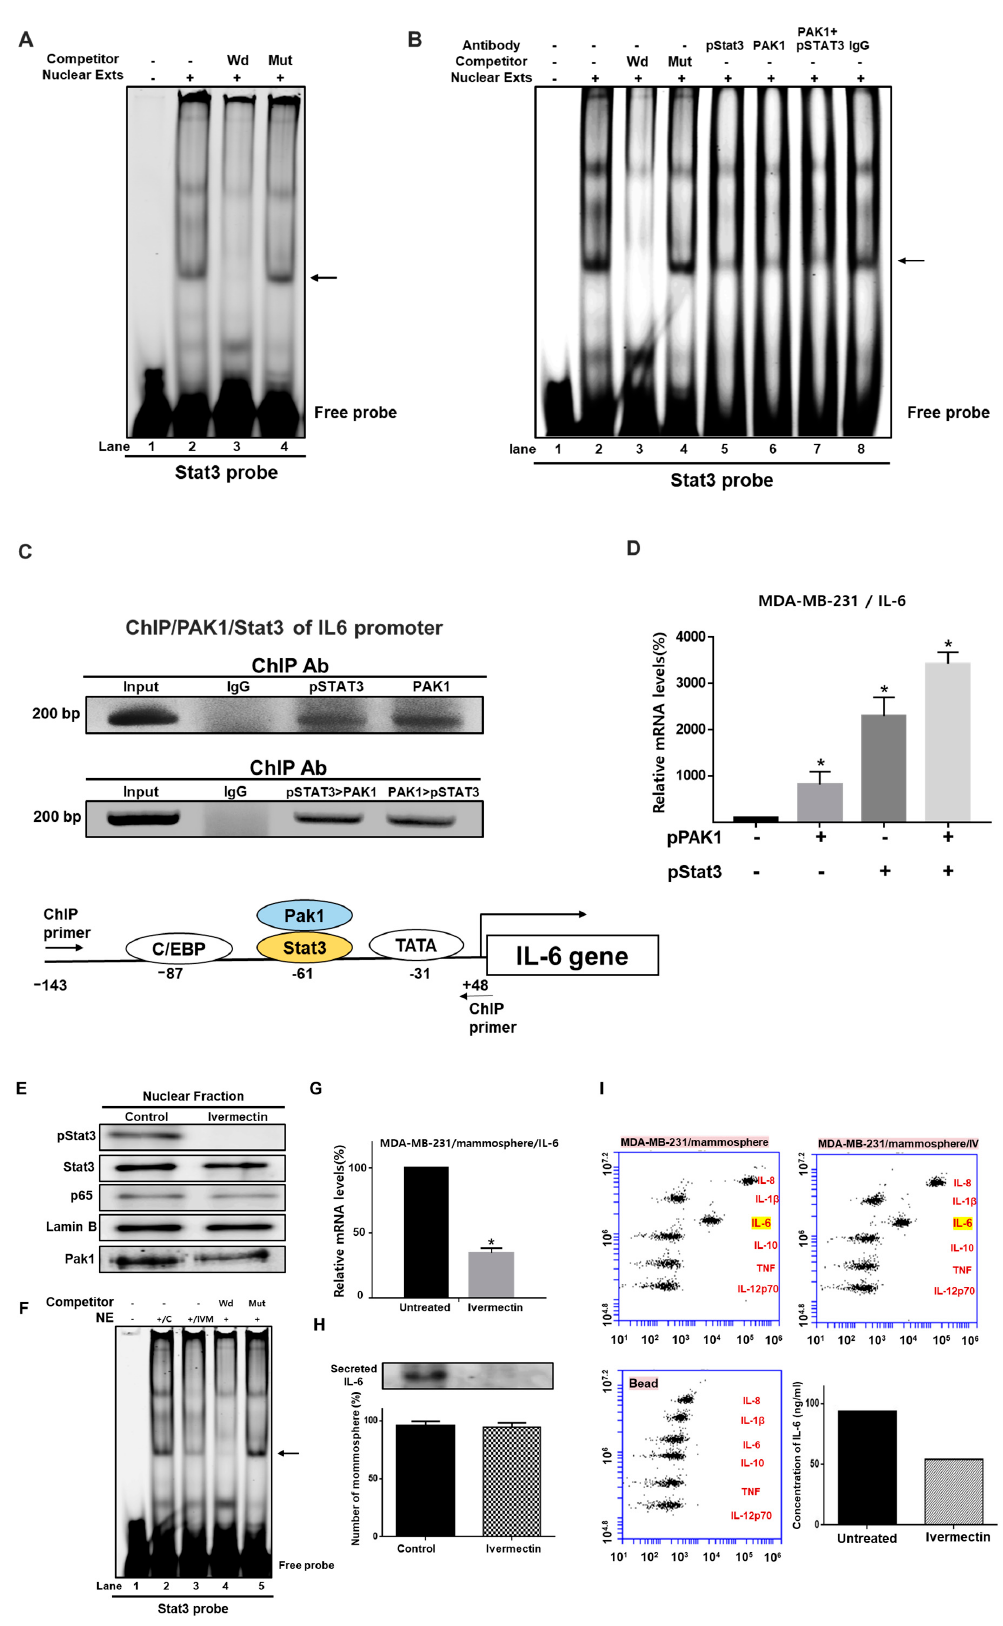
Figure 7. PAK1 a ff ects IL-6 gene expression through Stat3-mediated regulation. ( A ) Electrophoretic mobility shift assay (EMSA) using mammosphere nuclear proteins. Nuclear proteins were